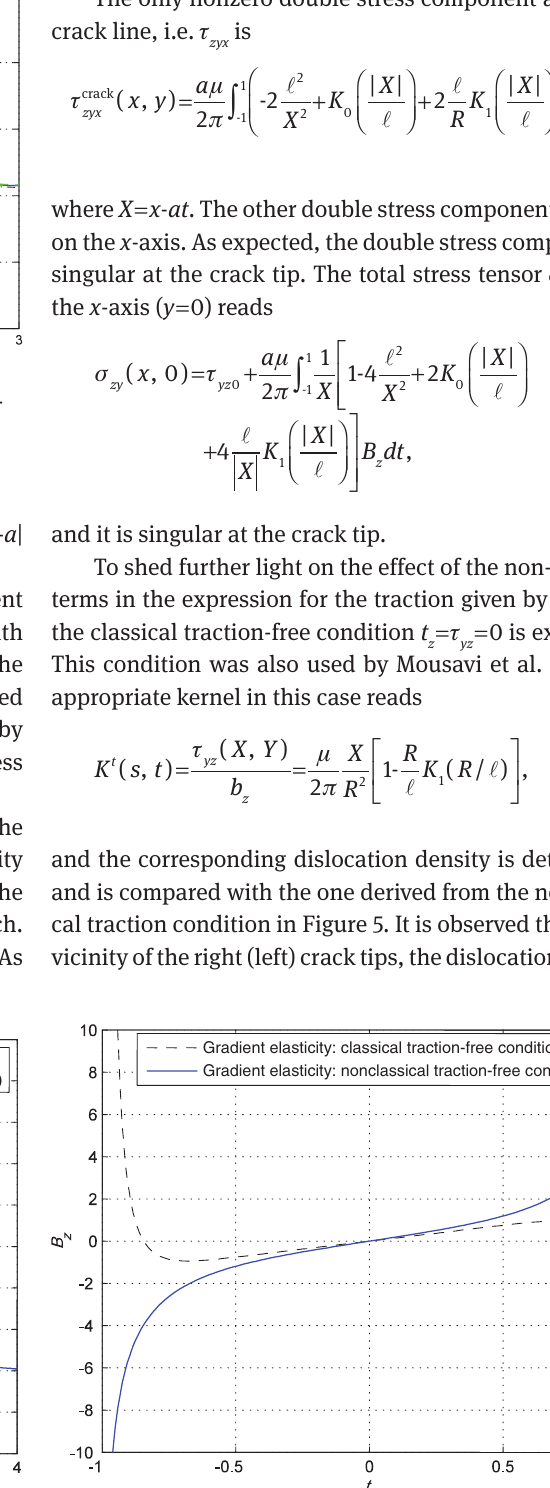
Figure 5: Dislocation density of crack for classical and nonclassical traction-free conditions in gradient theory.